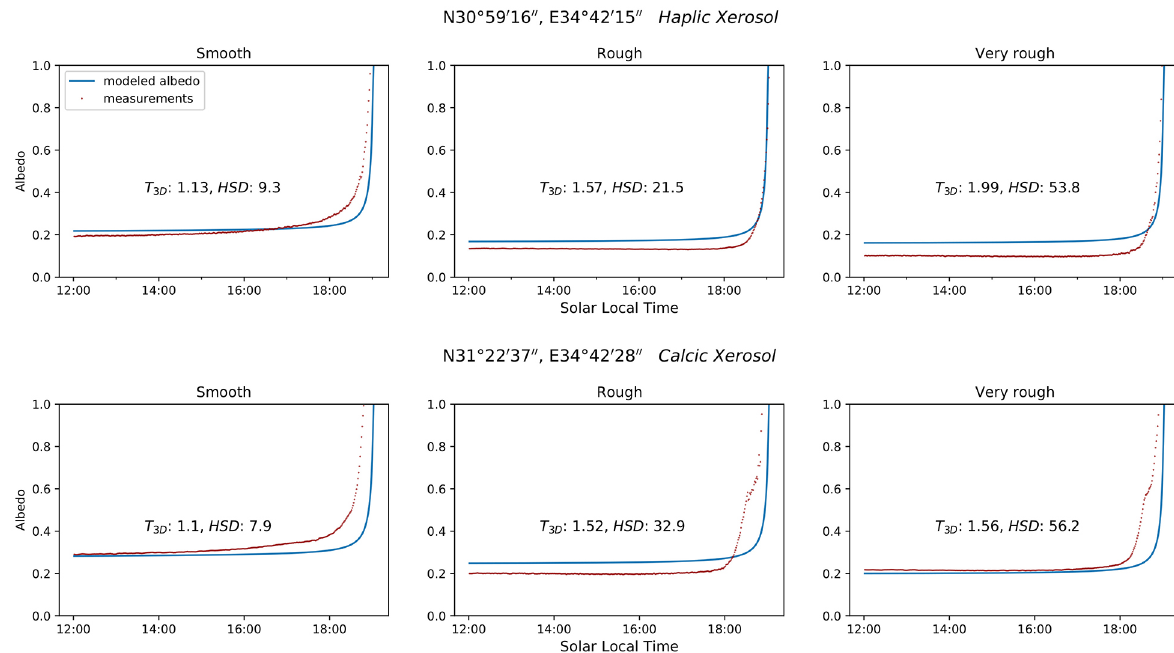
Fig. 8. A comparison between the measured a under field conditions and the clear-sky a modelled using SALBEC. SALBEC, Soil ALBEdo Calculator.